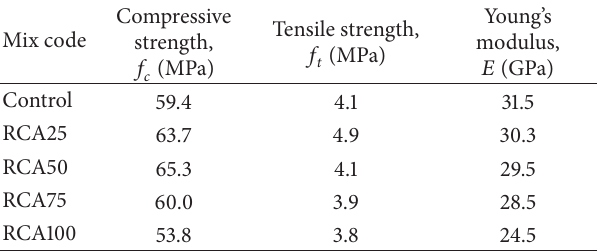
Table 4: Strength properties of control and RCAs.